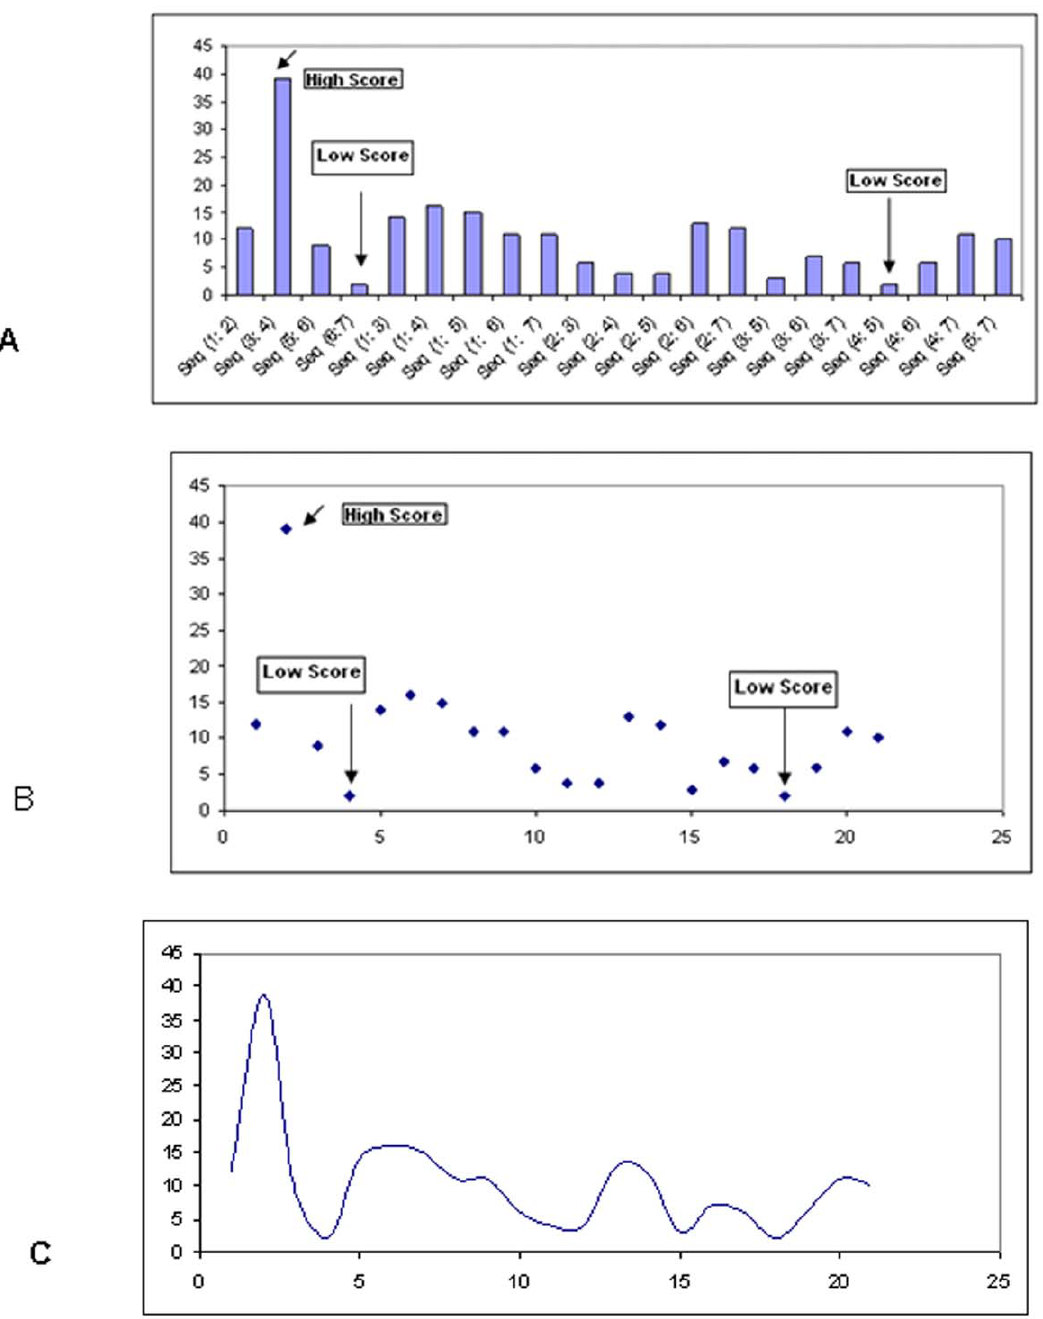
Figure 2. Alignment scores of protein sequences related to insulin resistance pathways. (A) Alignment score between sequences (notation Seq (x:y) meaning alignment score between sequence x, and sequence y), (B) scatter distribution of scores, and (C) scores connected by smoothed line without marker.